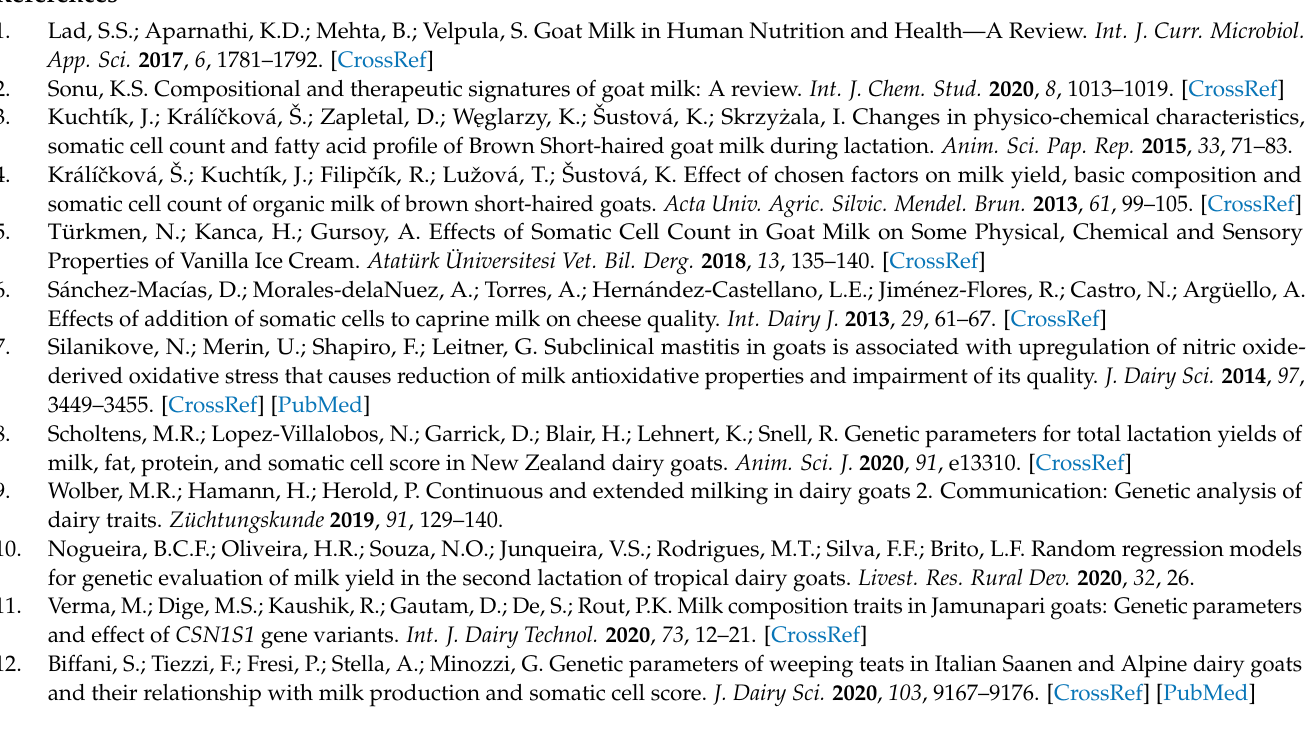
Figure S1: Electropherogram of SNPs in the Stearoyl-coenzyme A desaturase and Acetyl-CoA car- boxylase α gene analysed with Gene Mapper